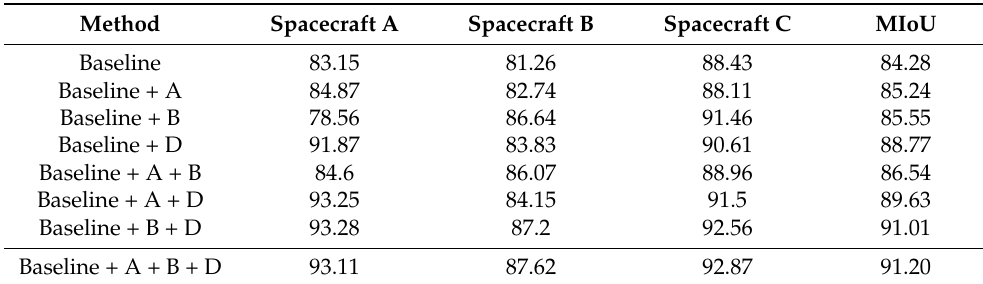
Table 7. The MIoU results of the ablation study on the test set.